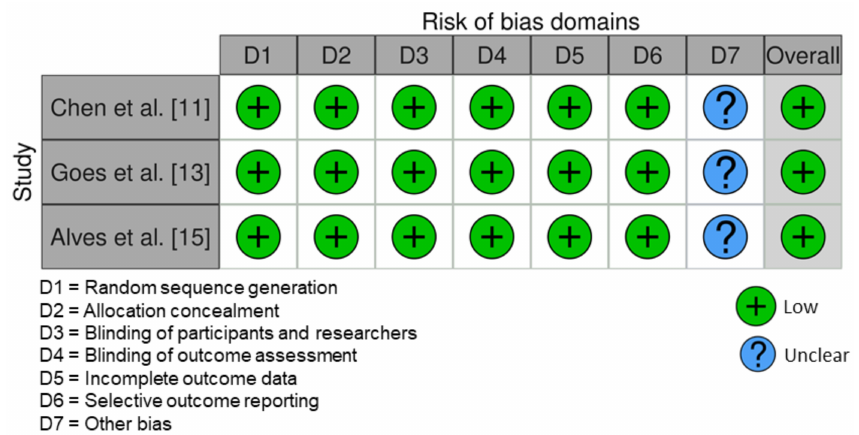
Figure 2. Risk of bias of the included randomized controlled trials.